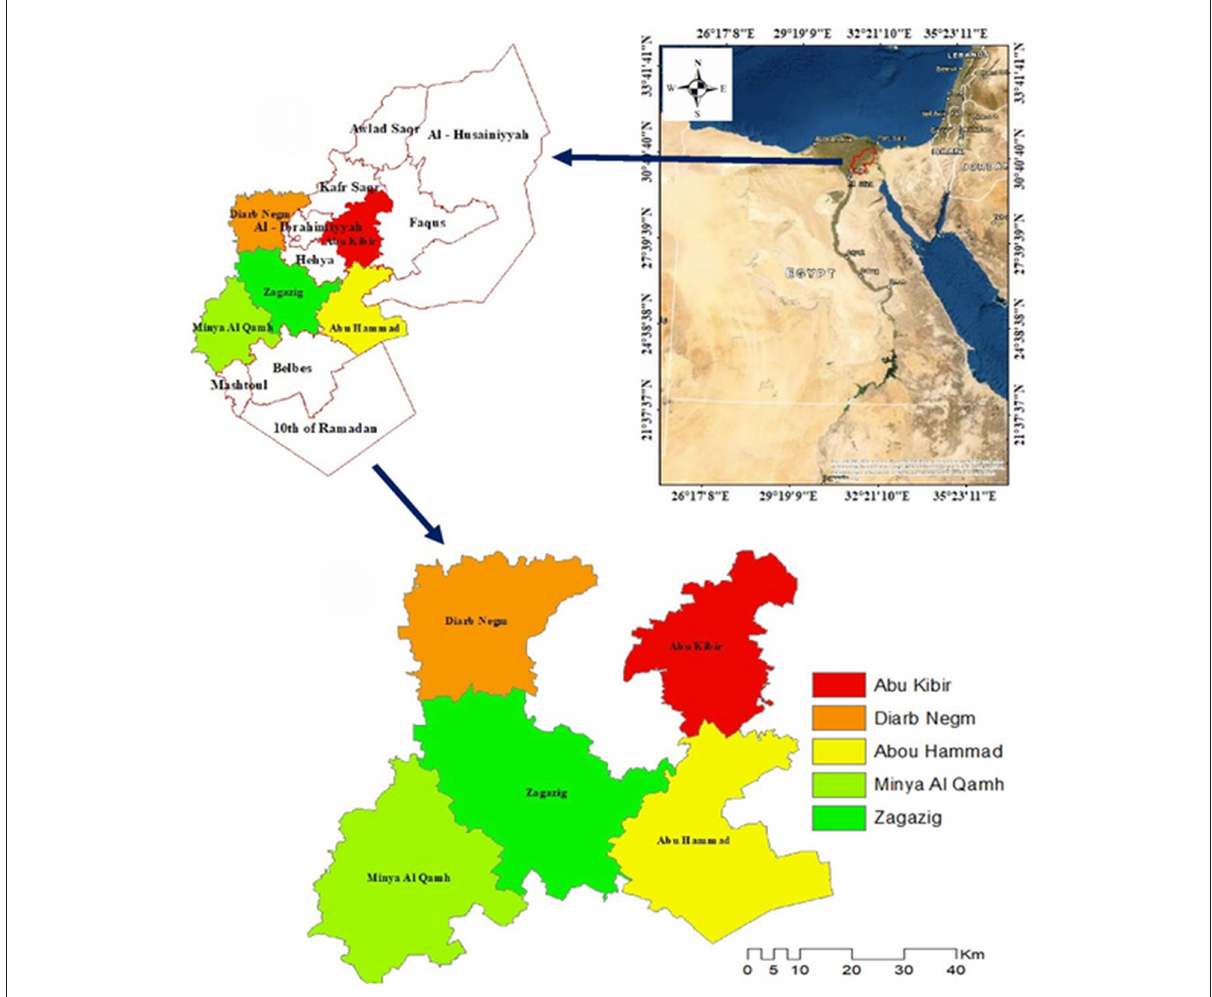
FIGURE1 Map of Egypt showing the location of Sharkia governorate and the five districts included in the study. The map was created using ArcGIS